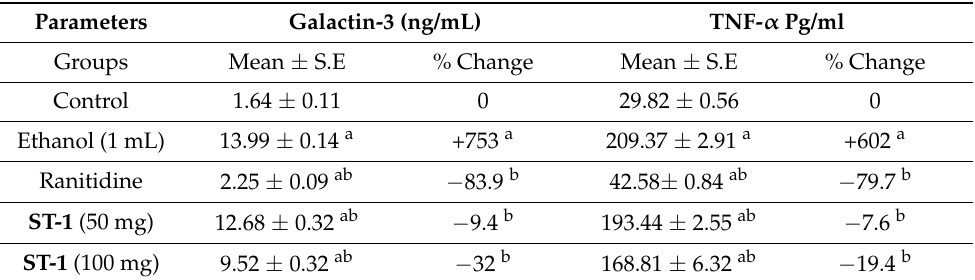
Table 1. Effects of oral administration of ST-1 on blood Galactin-3 (ng/mL) and TNF- α (Pg/mL) levels in ethanol-induced gastric ulcer in rats.